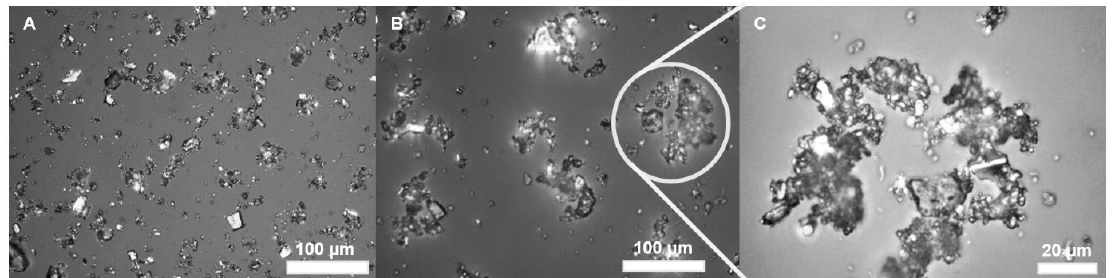
Figure 8. Optical microscope images of the dolomite sample ( A ), dolomite after coagulation with 50 mg · dm − 3 RL solution ( B ), and a zoom in on the aggregate ( C ). The magnification of samples A and B was 40× and 100× for sample C, respectively.